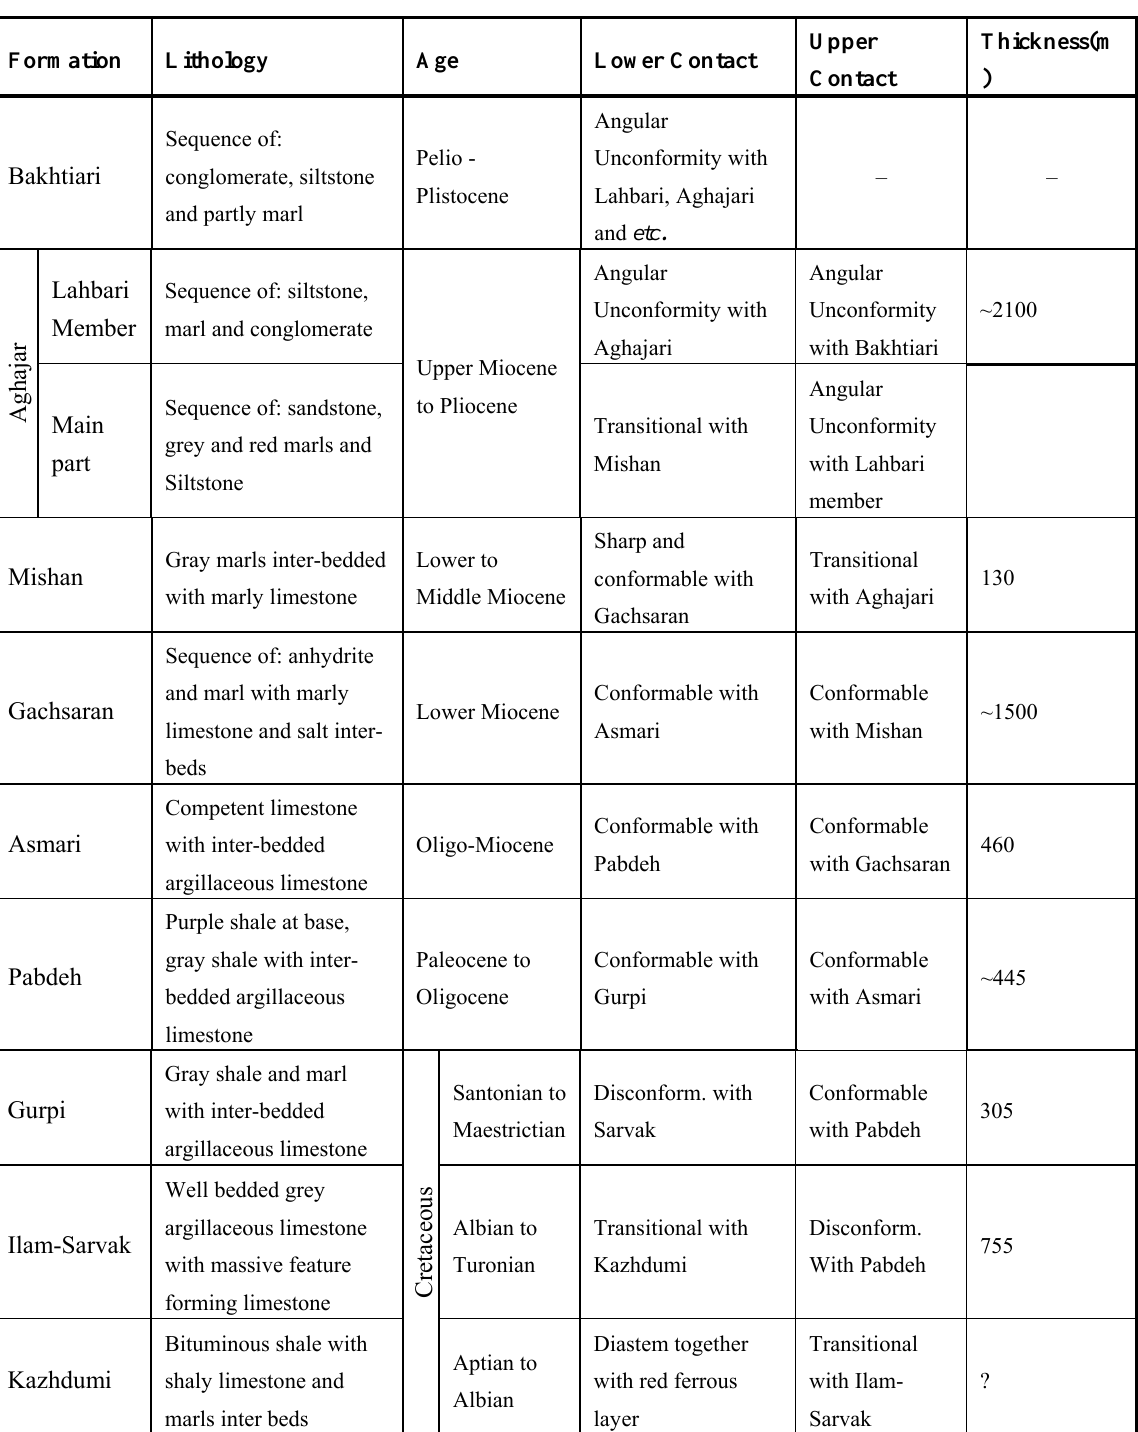
Table 1. Characteristics of outcropped formations in the study